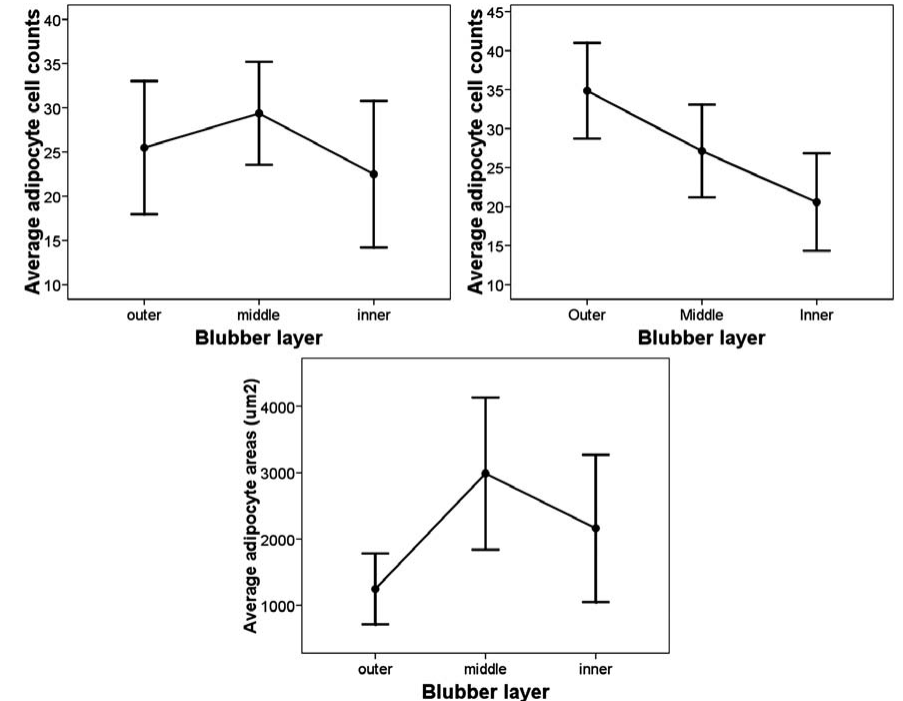
Fig. 3. – The pattern of mean adipocyte number in blubber layers for all positions except 2 (A), position 2 (B), and average adipocyte areas in each layer for all positions (C).